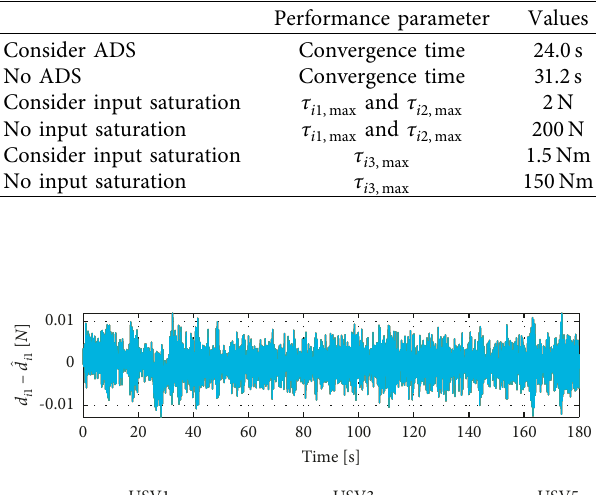
) of six USVs with the input i